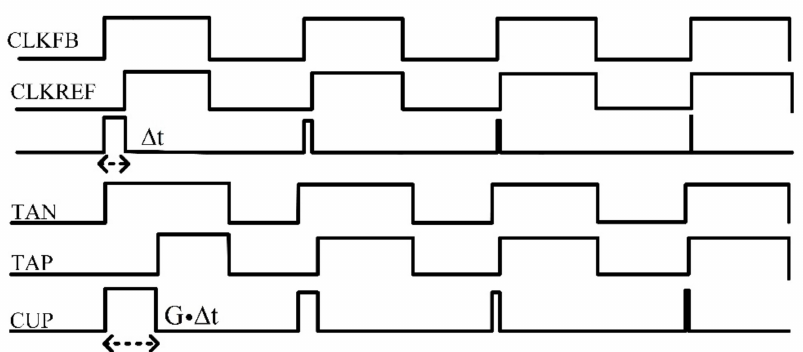
Figure 5. Phase error increase and